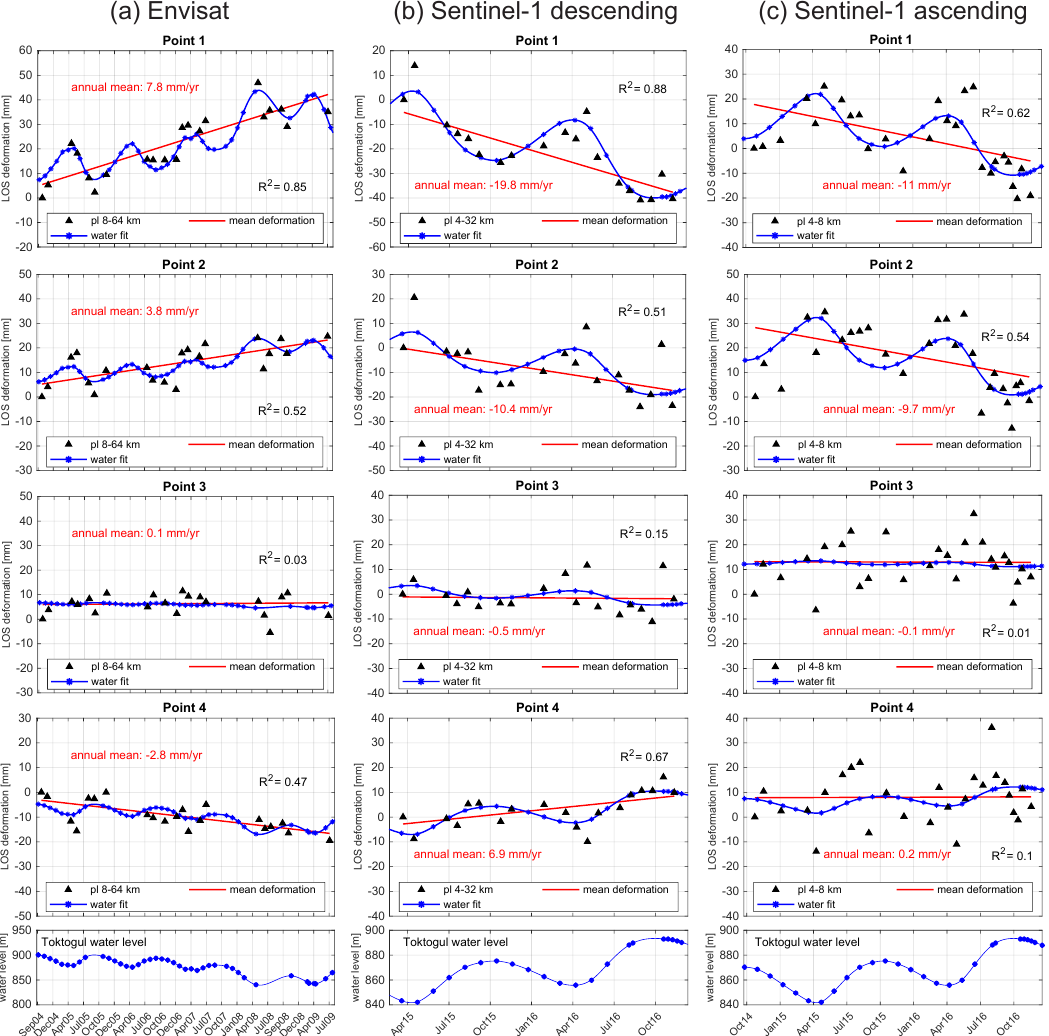
Figure 7. ( a ) Envisat; ( b ) S1d and ( c ) S1a power-law-corrected LOS deformation in time (black triangles) for points 1-4 as in Figure6. The red lines indicate the annual mean LOS deformation for the investigated time period. The blue lines in the bottom diagrams show the true Toktogul water level change, whereas the blue lines in the point figures represent the best fit of this water level to the shown